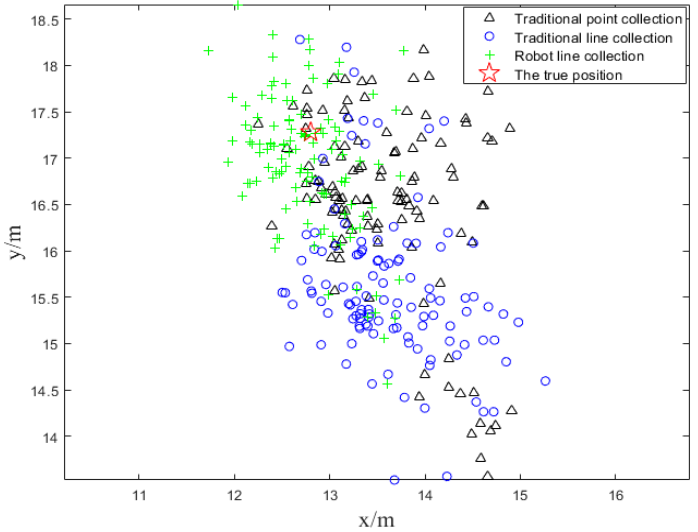
Figure 10. Positioning results of static test.